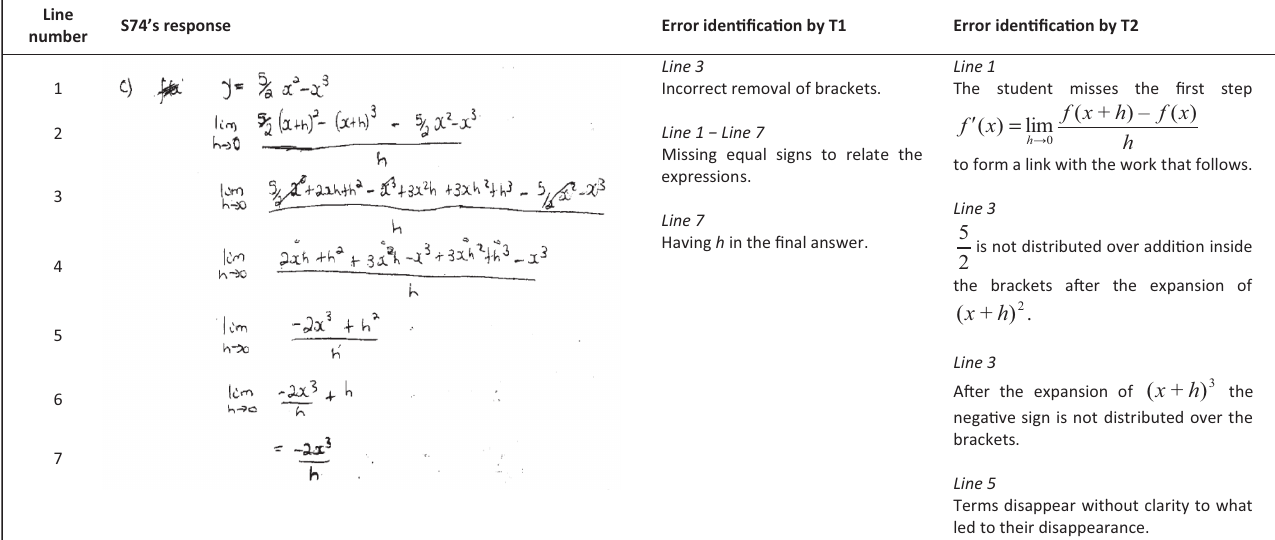
FIGURE 1: Error analysis of S74’s response.